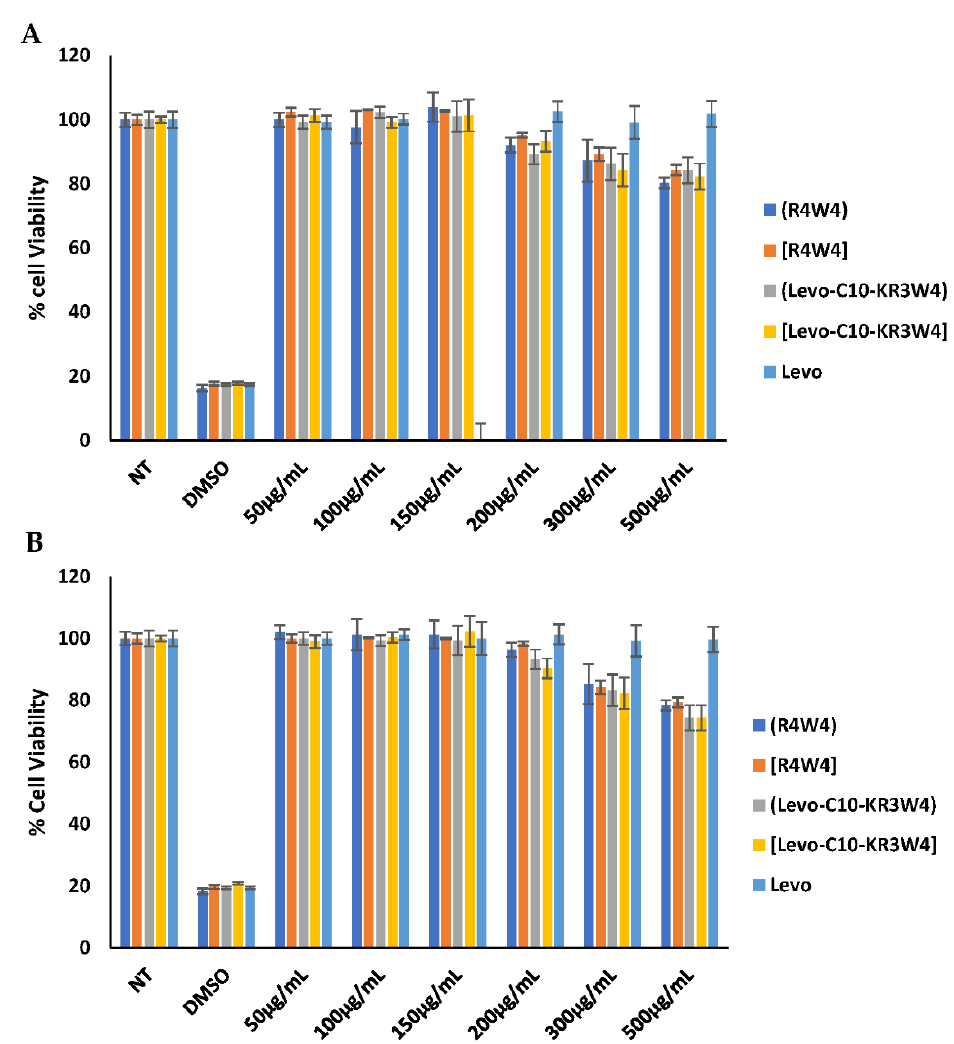
Figure 3. Cytotoxicity of peptides and their conjugates in ( A ) MDA-MB-231 cells and ( B ) in HEK-293 cells after 48 h incubation.